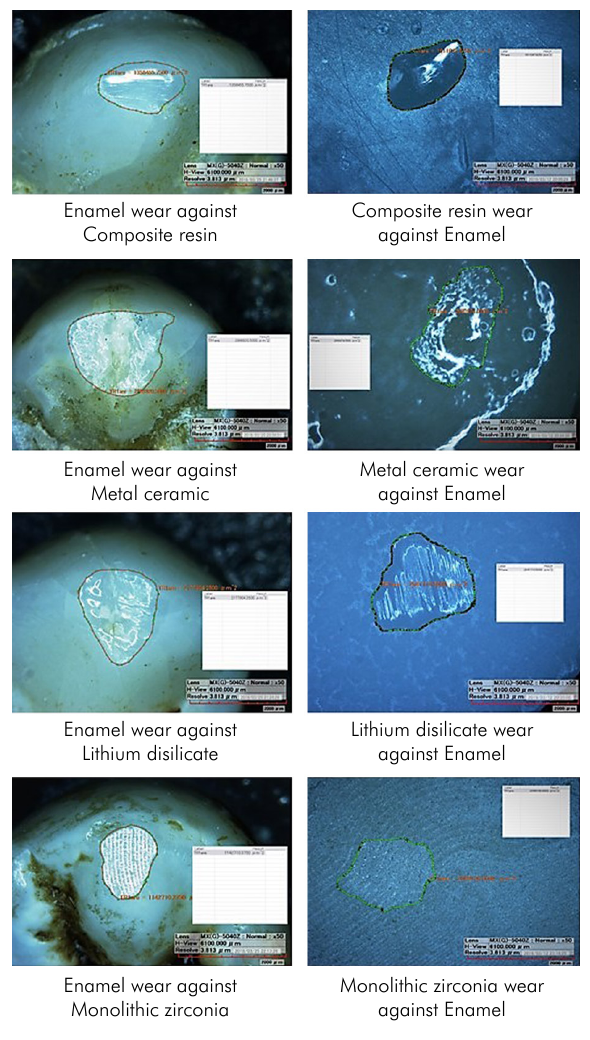
Figure 4. Post wear scans of enamel and material specimens and calculated wear facet surface areas ( μ m 2 ) using digital